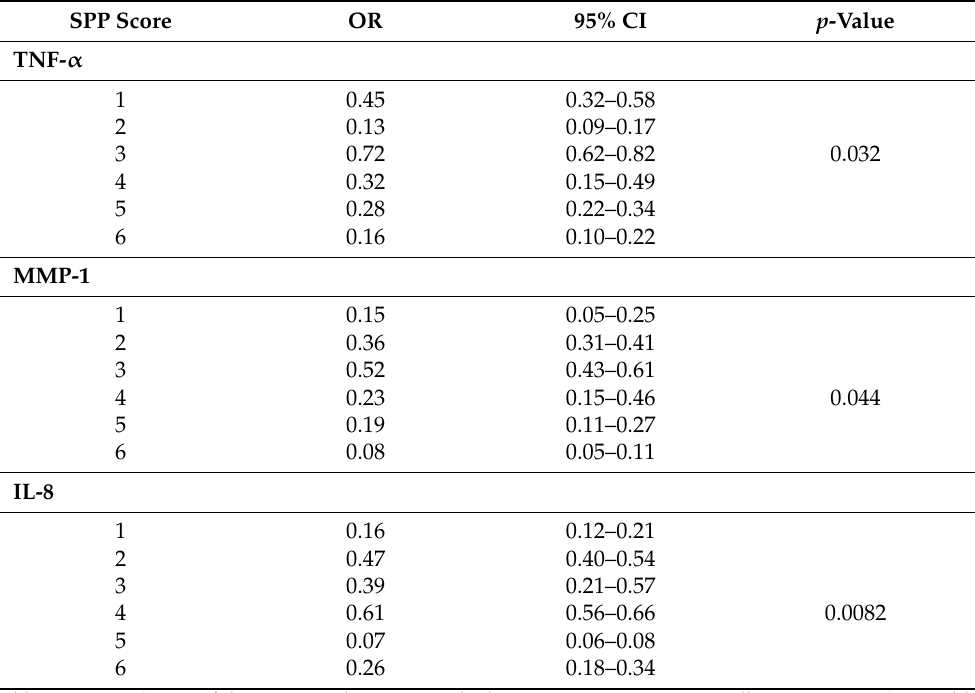
Table 4. Statistical comparisons of the SPP score with PICF cytokines